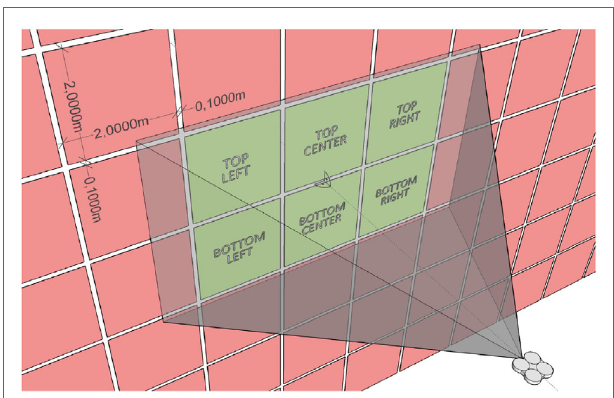
FigUre 5 | cell grid for surface maintenance . The quad-rotor divides the building facade in a grid of cells. The individual cells represent the immediate target areas to work on. Their states of cleanliness also provide the local cues for decision-making, i.e., for approaching an individual cell or to moving to another vantage point. © von Mammen et al. (2016) CC BY-NC-SA